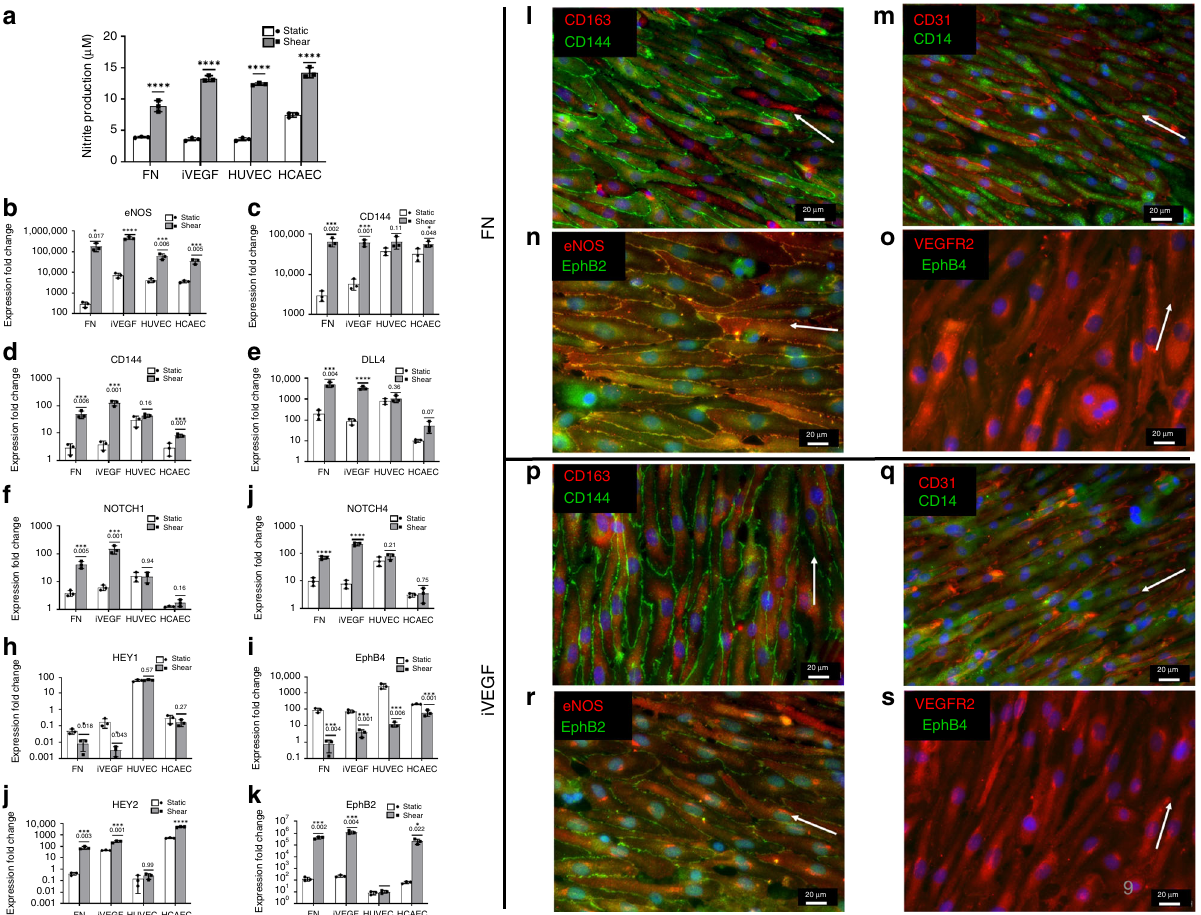
Fig. 8 Shear augments MC-to-EC differentiation. a High shear (10 dynes/cm 2 ) induces production of NO production in MC-EC cells differentiated on FN or iVEGFs as compared to static condition (gray bars). HUVEC and HCAEC were used as reference ECs capable of producing NO under shear. Statistical signi fi cance as indicated by p -values (**** p < 0.0001) determined by two-way ANOVA and Sidak ’ s test (DF = 16, F = 1390), n = 3 independent biological replicates; error bars denote ±SD of the mean. b – k MC-EC were subjected to high shear (10 dynes/cm 2 ) and expression of the indicated genes was measured by RT-PCR. Genes were internally normalized to RPL32 and compared to MC at day 0. Static (white bars) and shear (gray bars). HUVEC and HCAEC served as a reference EC cells. Statistical signi fi cance as indicated by p-values (**** p < 0.0001) determined by two-way ANOVA and Sidak ’ s test (DF = 16, F = 1390), n = 3 independent biological replicates; error bars denote ±SD of the mean. l – s Immunostaining for key MC and EC markers after exposure to high shear. FN or iVEGFs: ( l , p ) CD163 (red) and CD144 (green); ( m , q ) CD31 (red) and CD14 (green); ( n , r ) eNOS (red) and EphB2 (green); ( o , s ) VEGFR2 (red) and EphB4 (green). White arrows indicate the direction of fl uid fl ow. Scale bar: 20 µ m. Representative images of n = 5 independent biological